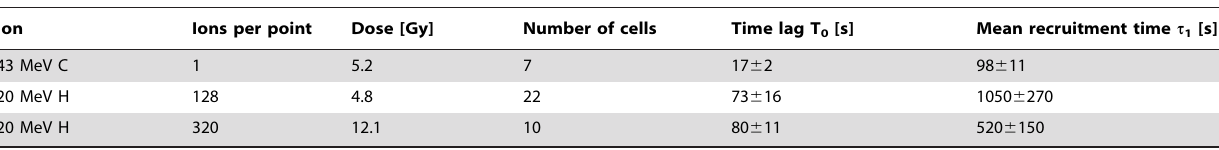
Table 1. Mdc1 kinetics.